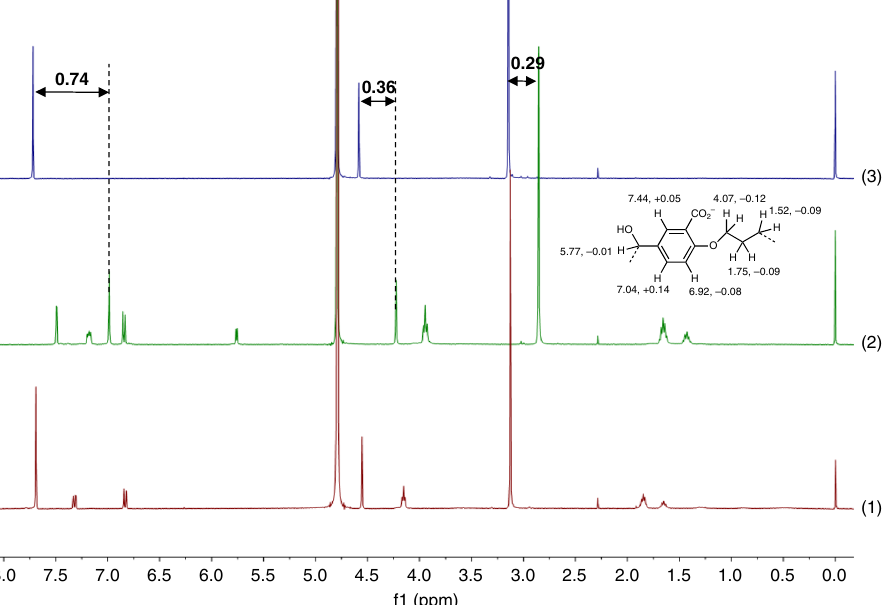
Fig. 2 1 H NMR spectral evidence for guest binding/non-binding. 1 H NMR spectra in D 2 O, pD 10.0. (1) 7 + 3 , (2) 7 + 4 and (3) 7 (all 10 − 3 M). Δ δ values for 7 caused by 4 are shown. Inset. δ values in the 1 H NMR spectra of 4 (a part structure is shown) and Δ δ values caused by 7